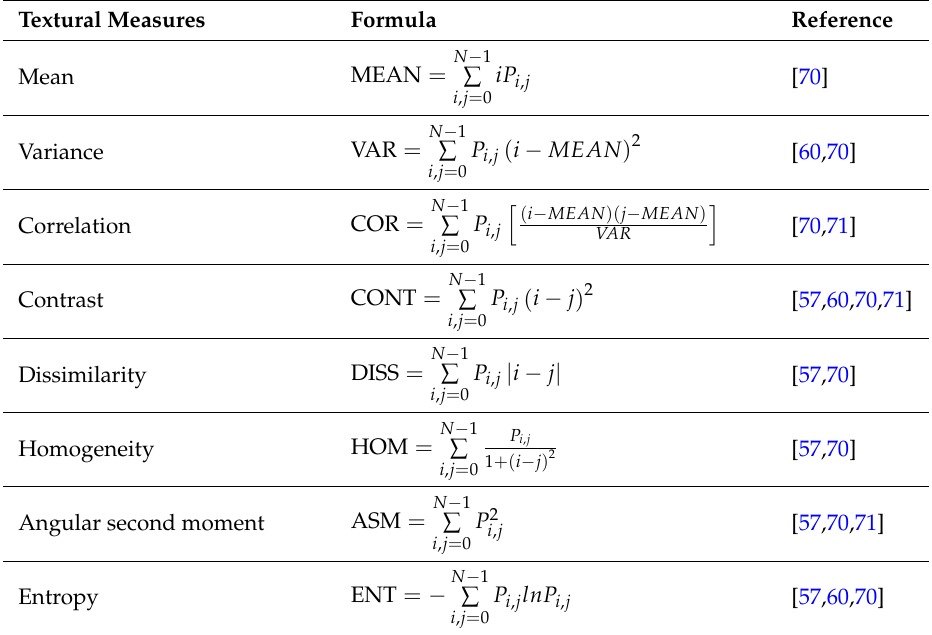
Table 2. The grey level co-occurrence matrix (GLCM) extracted from SPOT-5